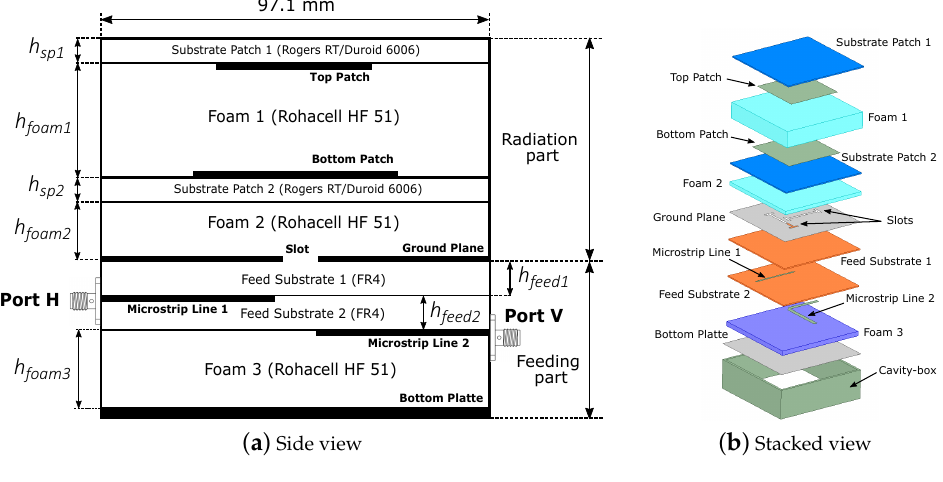
Figure 2. Antenna multilayer